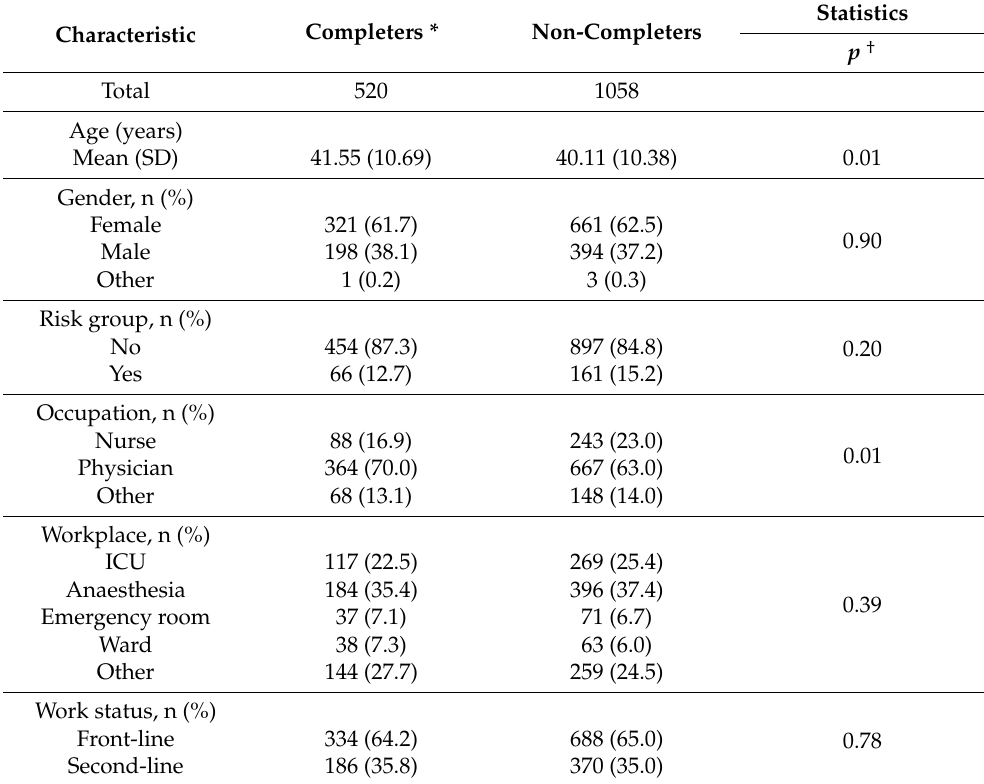
Figure 1. Study Flowchart. April 2020 (baseline—T0), July 2020 (T1), October 2020 (T2), January 2021 (T3), and April 2021 (T4). Table 1. Characteristics of the healthcare professionals included in this